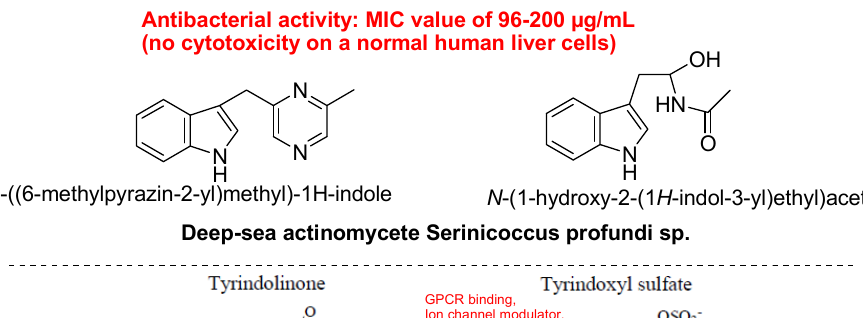
Figure 18. Indoles from deep sea